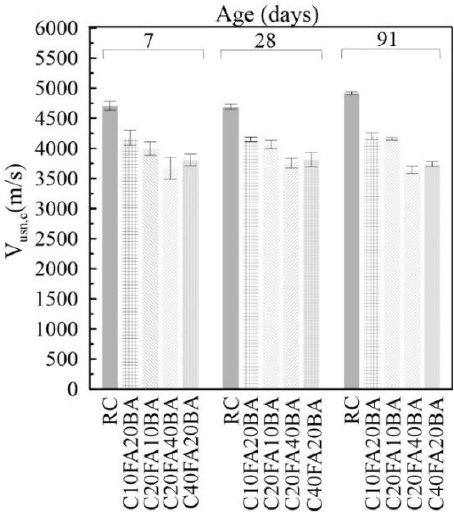
Figure 8. Ultrasonic pulse velocity at 7, 28 and 91